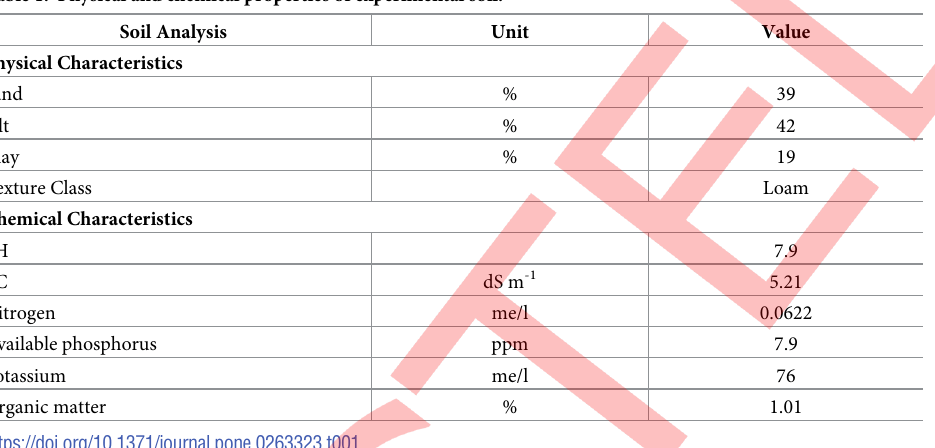
Table 1. Physical and chemical properties of experimental soil.